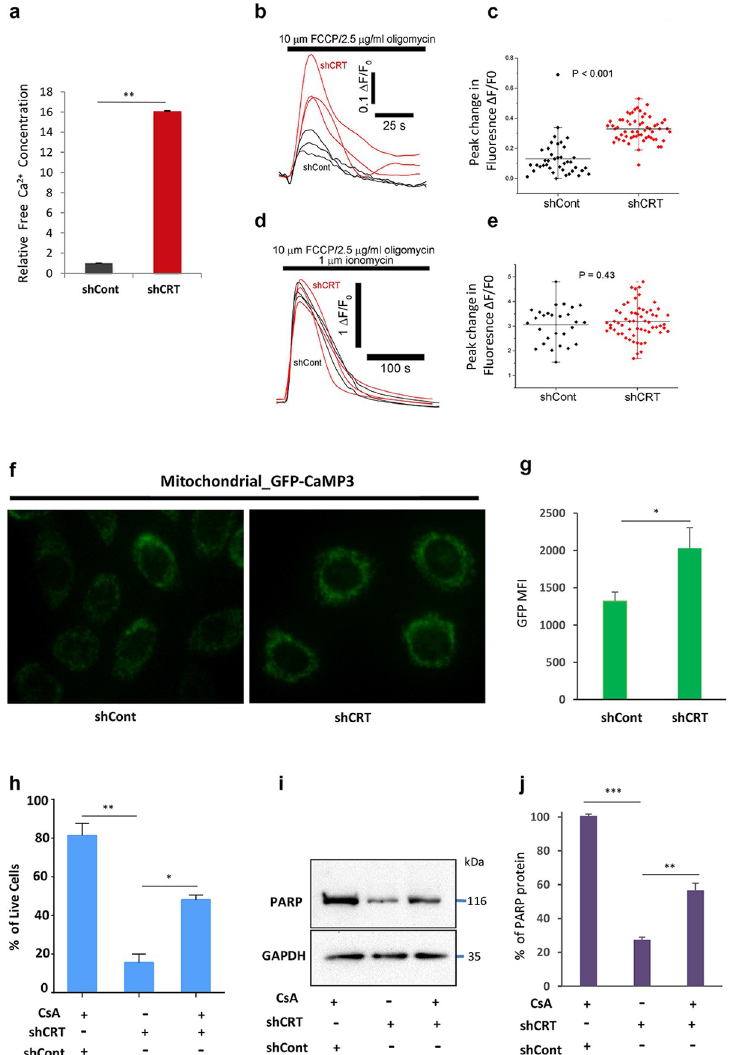
Fig 6. CRT down-regulation leads to the Ca 2+ overload of mitochondria and induction of CICD. (A) Quantification of free calcium levels in shCont- or shCRT-transduced cells using colometric Ca concentration kit. (B, C) Live whole-cell Ca 2+ imaging of mitochondrial Ca 2+ stores, quantified at the single-cell level after administration of FCCP and Oligomycin. (D, E) Live whole-cell Ca 2+ imaging of mitochondria-independent Ca 2+ stores, quantified at the single-cell level after administration of FCCP/Oligomycin followed by the addition of Ionomycin. (F) HeLa cell expressing mito- GFP-CaMP3 were transduced with lentiviral particles of shCRT and shCont, and GFP fluoresce was analyzed using Inverted Nikon microscopy system or (G) FACS Instrument, BDCallibur (MFI is plotted on the Y- axis). (H) Viability quantification of the indicated cells after they were grown in the presence of CsA following their transduction with shCRT or shCont. (I, J) Western blot analysis and quantification of PARP full-length protein levels after indicated cells were grown in the presence of CsA. Underlying source data can be found in S1 Data. Unpaired Student t test was used to calculate P -values ( � p < 0.05, �� p < 0.005). All error bars indicate mean ± SD. CICD, Caspase-independent cell death; CRT, calreticulin; CsA, cyclosporin A; FACS, fluorescence activated cell sorting; FCCP, Carbonyl cyanide-4-(trifluoromethoxy)phenylhydrazone; GAPDH, Glyceraldehyde 3-phosphate dehydrogenase; GFP, Green fluorescence protein; HeLa, Human cervical adenocarcinoma cell line; MFI, mean fluorescence intensity; mito-GFP-CaMP3, mitochondrial genetically encoded calcium indicator 3, created from a fusion of green fluorescent protein, calmodulin, and M13, a peptide sequence from myosin light chain kinase; PARP, poly ADP ribose polymerase; shCont, short hairpin RNA targeting Control; shCRT, short hairpin RNA targeting Calreticulin.